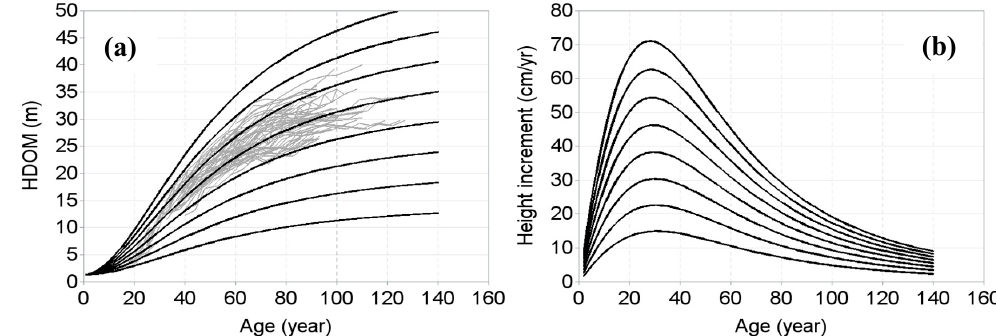
Figure 3. Dominant height (HDOM) development curves overlaid on the measured HDOM data ( a ); HDOM increment curves for site index classes formed with 5 m interval between 12 m and 47 m (b).